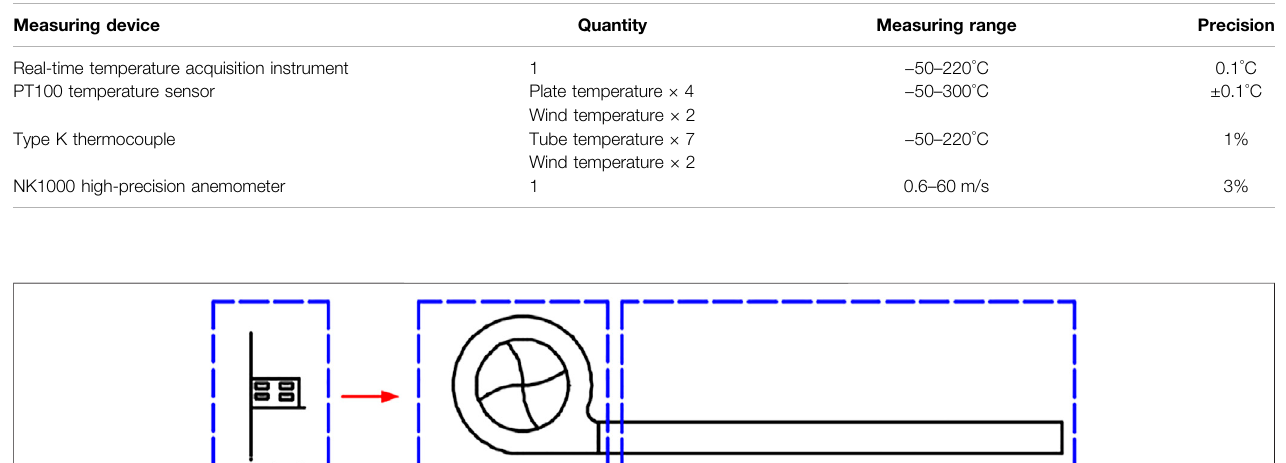
TABLE 2 | Experimental measuring devices.